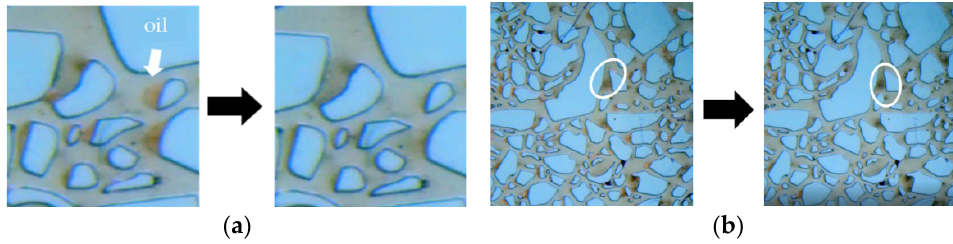
Figure 5. ( a ) Miscibility and ( b ) Extraction .